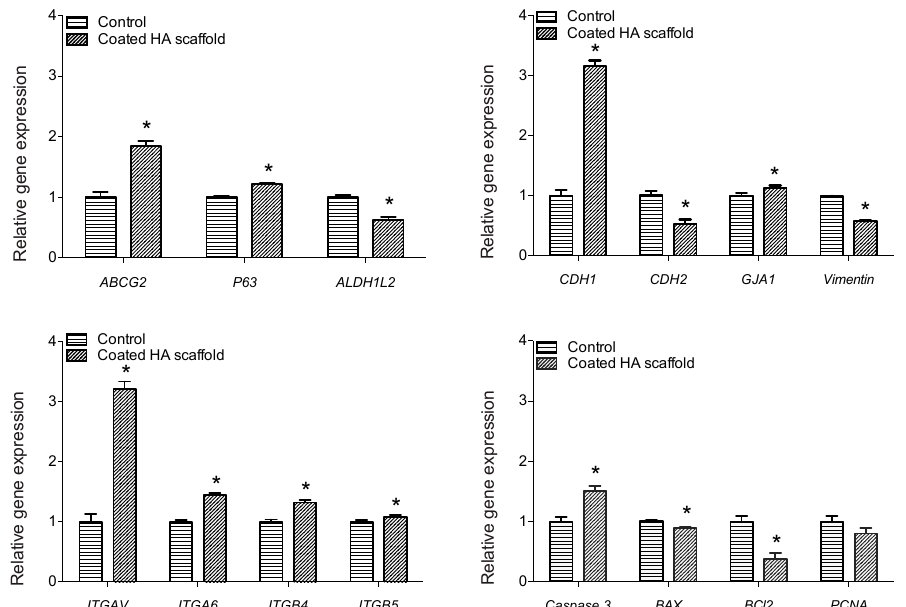
Figure 6. Real-time polymerase chain reaction (RT-PCR) analysis of the expression of 15 genes ( ABCG2 , Δ Np63 α , ALDH1L2 , CDH1 , CDH2 , GJA1 , Vimentin , ITGAV , ITGA6 , ITGB4 , ITGB5 , CASP3 , BAX2 , BCL2 and PCNA ) in human OMECs after three weeks of culture on 3-day old HA scaffold coated with 1 mg/mL collagen IV relative to control (seeded cells on collagen IV coated plastic multiwall plates), which was chosen as calibrator. Asterisks (*) above the bar denote significant differences ( p ≤ 0.05). Table 4. The gene expression data as fold change in a 3-week culture of OMECs on 3-HAC4 compared to control OMEC sheets grown on collagen IV-coated plastic.